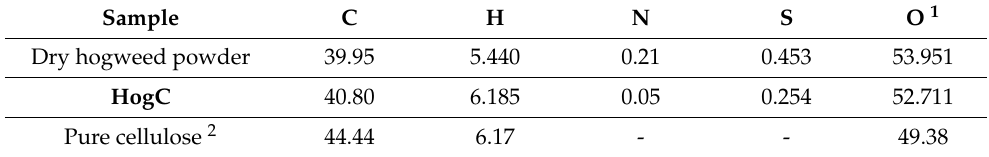
Table 1. Elemental composition of dry hogweed powder, HogC and pure cellulose (in wt %).